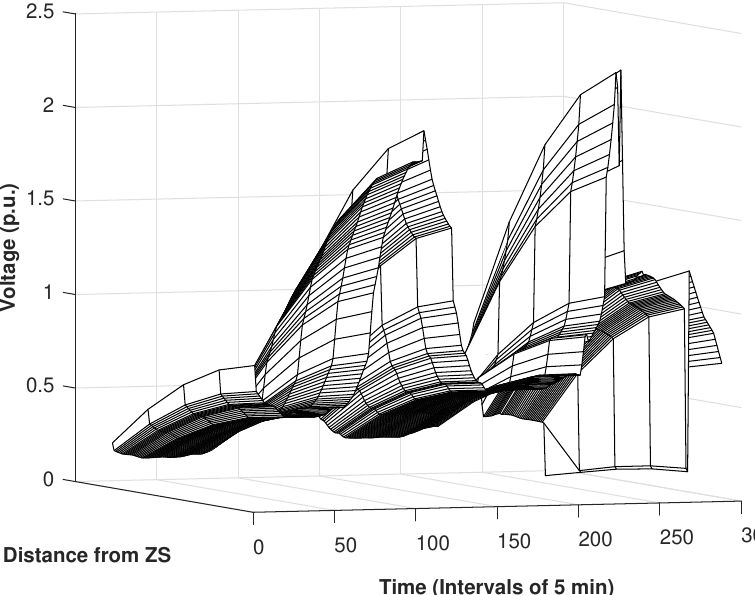
Figure 11. VUF in the LV network before using the proposed volt/var control method.